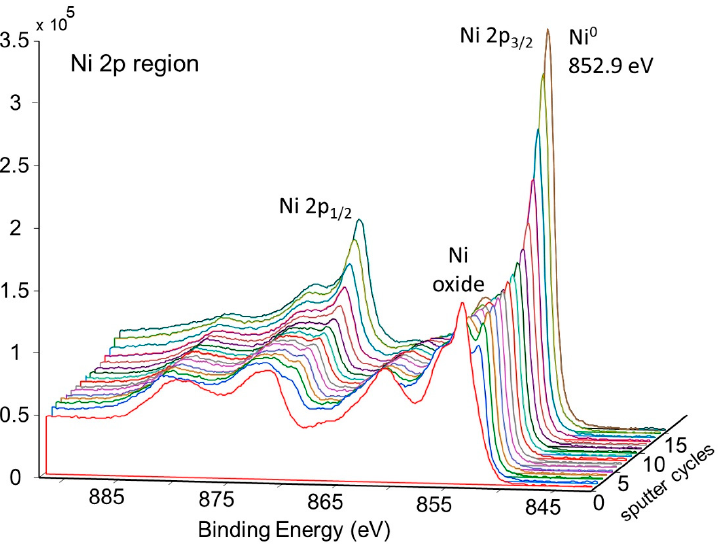
Figure 12. Depth profile for pretreated and activated d-sample showing decrease of NiO and increase of metallic Ni with depth .